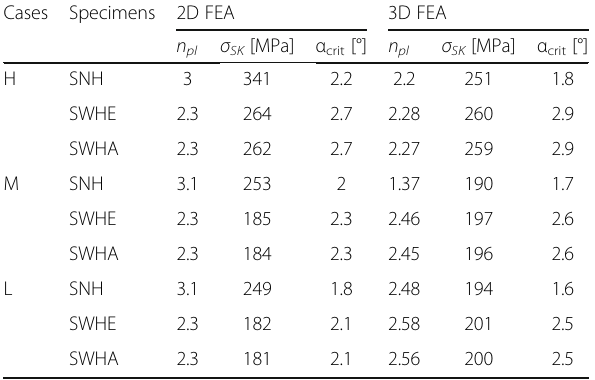
Table 12 Static strength and critical angles of the specimens with the cortical bone considered as ductile Cases Specimens 2D FEA